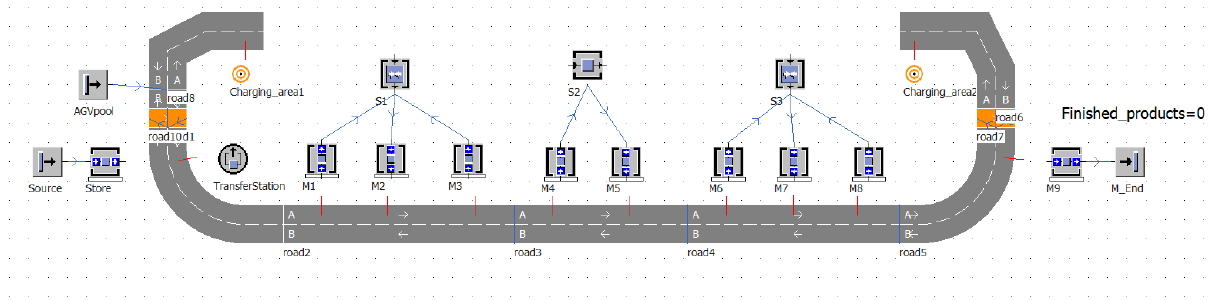
Figure 9. The layout diagram of an assembly line. Table 1. Machining time of each station and the meaning of symbols.